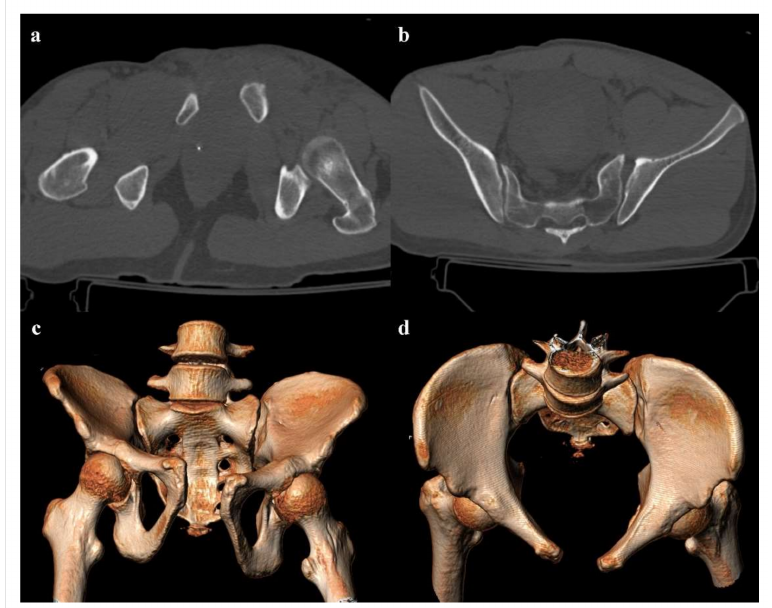
Figure 5. Anterior–posterior compression fracture, type 2. Axial CT images ( a , b ) show a pubic symphysis diastasis of 3.2 cm, and an anterior sacroiliac joint diastasis on the left side. Three- dimensional volume-rendering CT reconstructions in outlet and inlet views ( c , d ) confirm the findings.